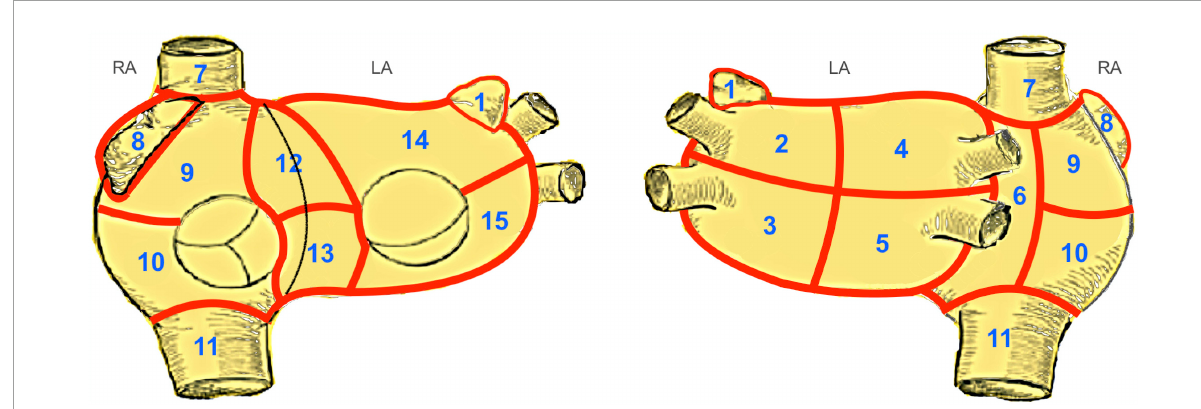
FIGURE1 Modified Bordeaux Atrial Region Classification. The original Bordeaux atrial region classification (1) divides the CT-based atrial geometry into seven regions to provide distinct anatomical classification. We modified this classification keeping the same principles of bi-atrial regional subdivision into 15 zones guided by endocardial and epicardial ablation schemes. Zones 1–5, 14 and 15 correspond to the left atrium. Zones 12 and 13, the anterior interatrial groove, covers a region between both atria, belonging equally to both. The zones 6–11 correspond to the right atrium. LA, left atrium; RA, right atrium; 1, left atrial appendage; 2, region of left upper PV; 3, region of left lower PV; 4, region of right upper PV; 5, region of right lower PV; 6, posterior interatrial groove; 7, inflow of superior vena cava; 8, right atrial appendage; 9, upper region of right